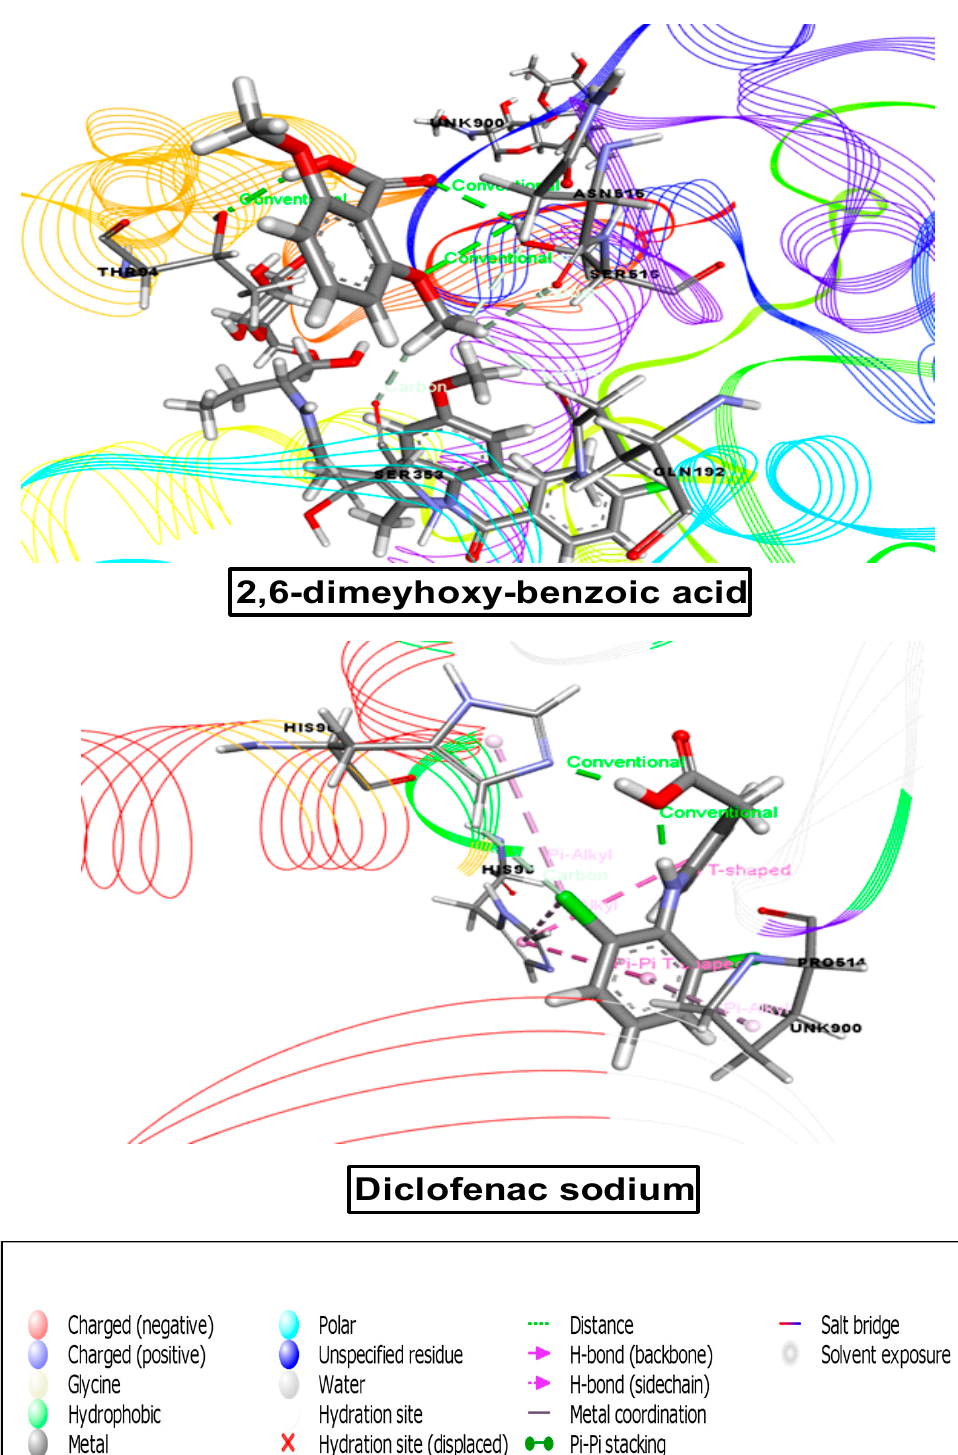
Figure 7. Best ranked pose of the major compounds of M. capitulata . 2,6-dimeyhoxy-benzoic acid and standard drug (diclofenac sodium) in the binding pocket of COX-1 enzyme (PDB ID: 2OYE) for analgesic and anti-inflammatory activities.